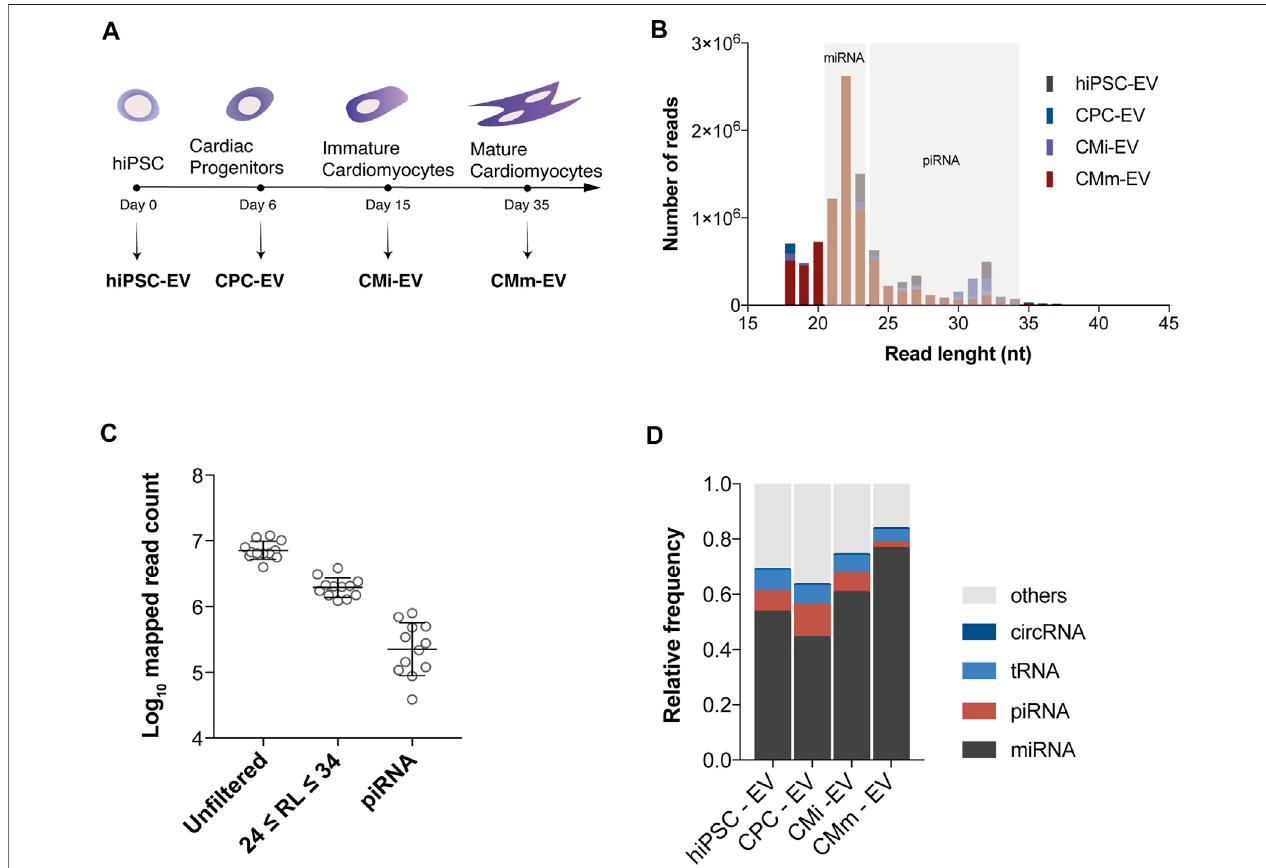
FIGURE 1 | piRNA transcripts are present in extracellular vesicles. (A) Schematic timeline for isolation of extracellular vesicles (EV) over hiPSC-CM differentiation andmaturation.EVwereisolatedfromconditionedculturemediaatthehiPSC(hiPSC-EV),cardiac progenitor(CPC-EV),immature(CMi-EV),andmaturecardiomyocyte (CMm-EV)stages. (B) Lengthfrequencyofun fi lteredmappedreads(averageofthreebiologicalreplicates).GrayareasdenotethesizerangeformiRNAsandpiRNAs. (C) Numberof mapped reads forall samplesbefore processing (un fi ltered), after fi lteringbyread length(RL) in thesize range ofpiRNA, and bybiotype. (D) Distribution of small RNA biotypes relative to reads used for alignment, for each EV population studied. Each fraction represents the mean of three replicates.